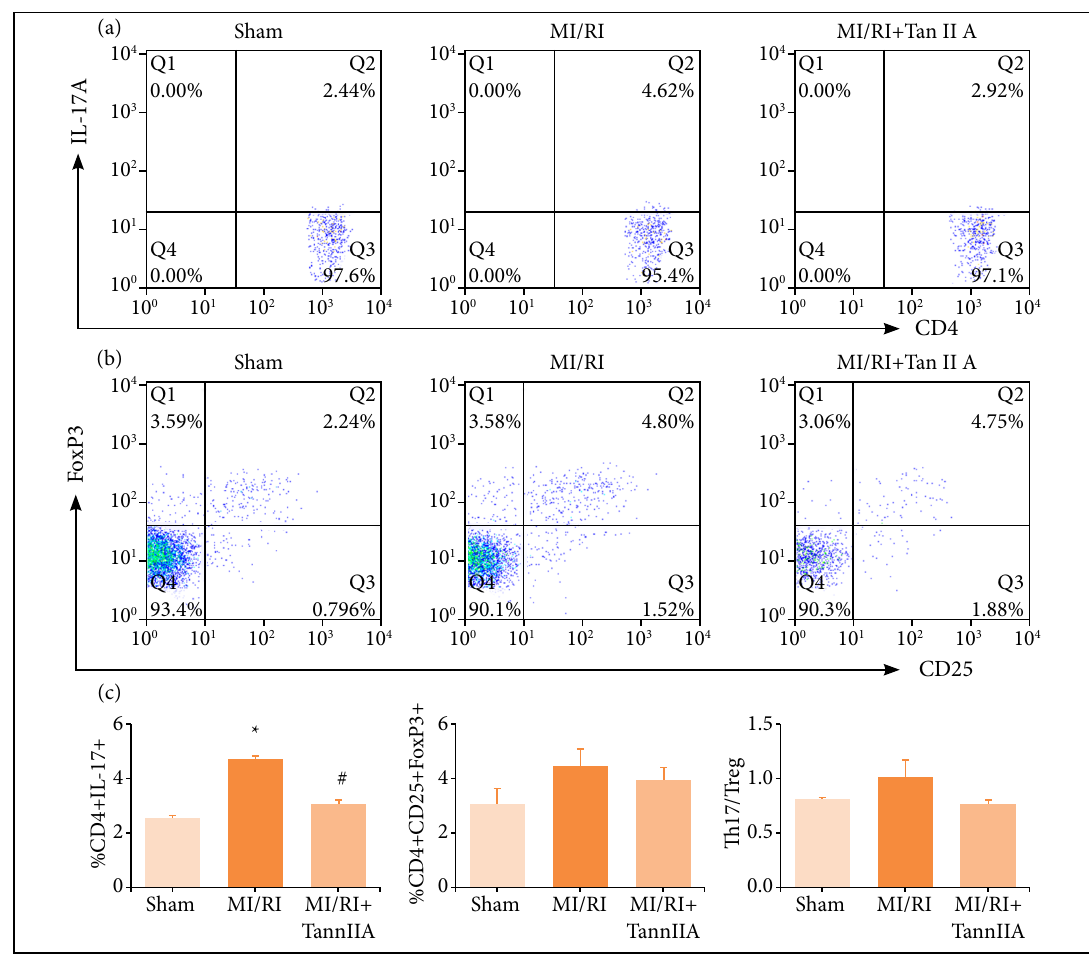
Figure 3 - Effect of tanshinone IIA on T cells differentiation in peripheral blood. Representative flow samples of (a) CD4+IL17A+ and (b) CD4+CD25+FoxP3+ were shown from each sample. (c) Quantification of cell frequency of Th17(CD4+IL17A+), Treg (CD4+CD25+FoxP3+) and Th17/Treg (n ≥